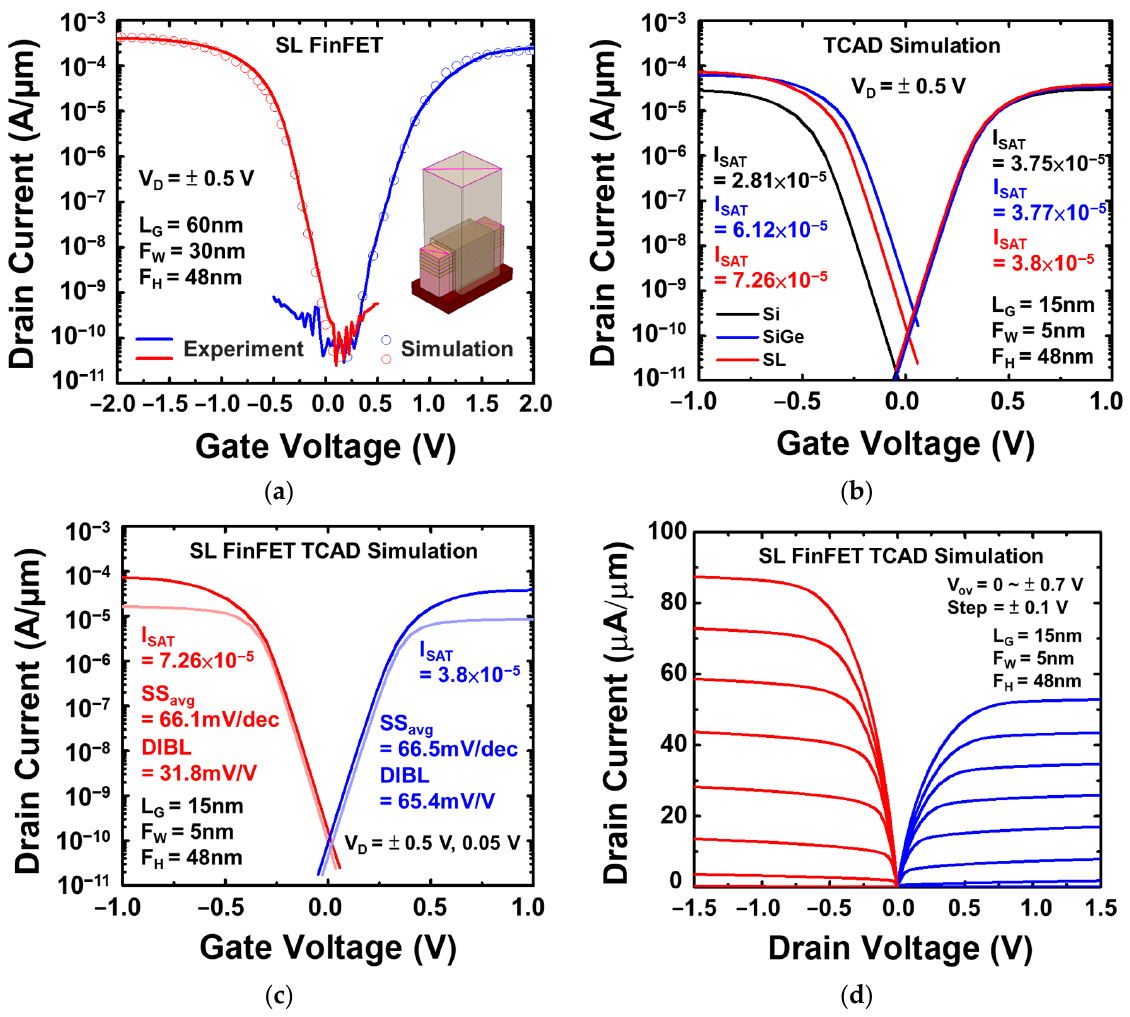
Figure 12. ( a ) The calibrated I D -V G characteristic of the Si 0.8 Ge 0.2 /Si SL FinFET between experimental data and TCAD simulation. ( b ) The simulated I D -V G characteristics of Si 0.8 Ge 0.2 /Si SL, Si 0.8 Ge 0.2 , and Si FinFET for comparison, ( c ) the simulated I D -V G and ( d ) I D -V D characteristics of Si 0.8 Ge 0.2 /Si SL FinFET, both with L G = 15 nm and F W = 5 nm according to state of the art and a total fin height of 48 nm and HfO 2 = 4nm, as used in the experiment of this